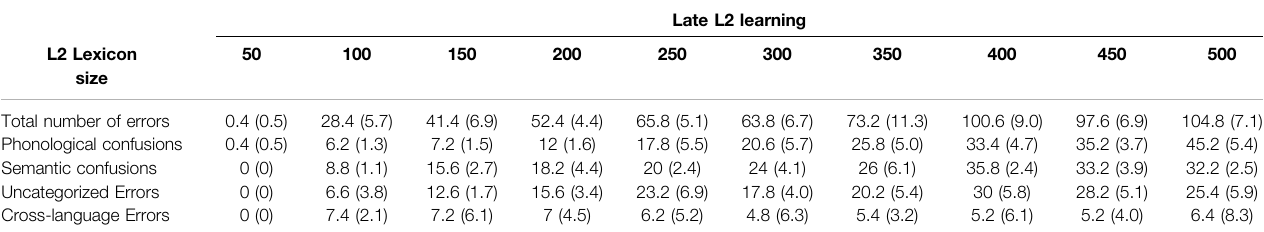
TABLE 1| Numberofeach typeofcomprehensionerrorsinL2(English)acrossdifferentlateL2learningstages. Resultsaveragedover5simulations foreachlearningstage. Standard deviations are listed within the